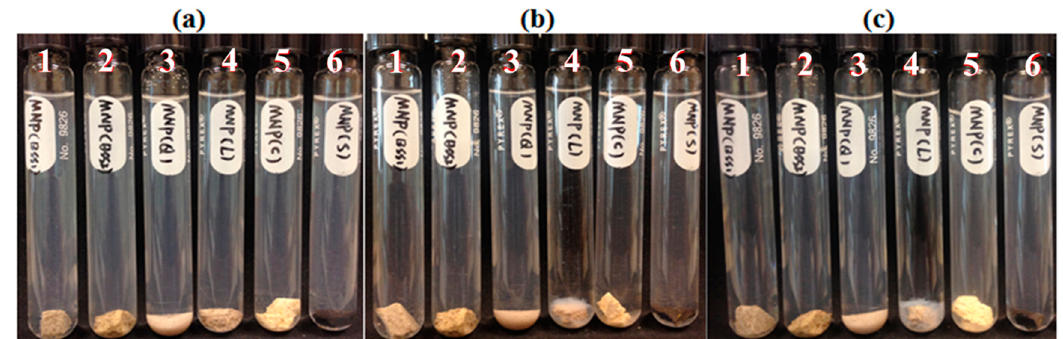
Figure 8. FNP-MD suspensions with reservoir rocks: ( a ), Day 0; ( b ), Day 7; ( c ), Day 30. (1: BBS1; 2: BSS2; 3: quartz; 4: limestone; 5: chalk; 6: shale).